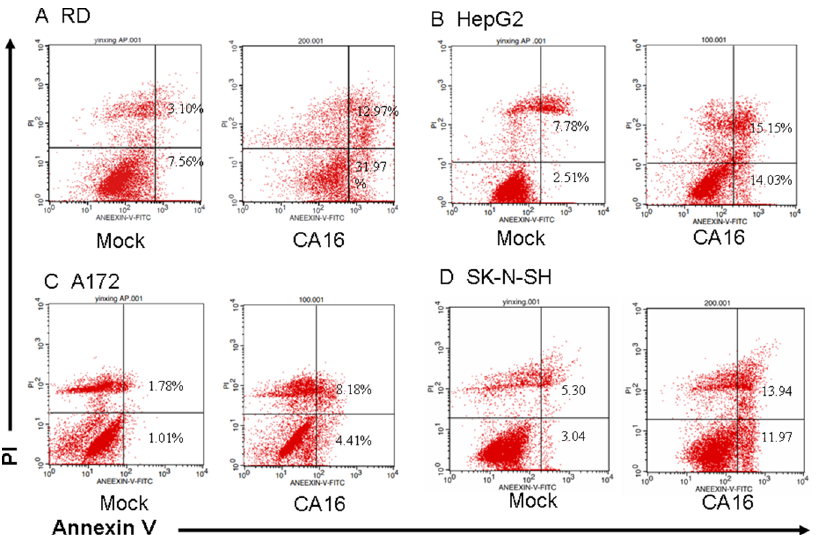
Figure 4. Membrane changes associated with apoptosis in CA16-infected cells. (A) RD, (B) HepG2, (C) A172 and (D) SK-N-SH cells were inoculated with CA16 SHZH05 virus at the MOI of 1.0, 2.0, 1.0 and 1.0, respectively, or DMEM as a negative control for 24 h. Cells were washed with PBS, incubated with FITC-labeled Annexin V and stained with PI, followed by analysis via flow cytometry. Annexin V-positive/PI-negative cells were considered to be in early phase apoptosis. Annexin V-positive/PI-positive cells were considered to be in late phase apoptosis. Representative images are shown of three individual experiments (n=3) performed for each cell line. * P , 0.05.